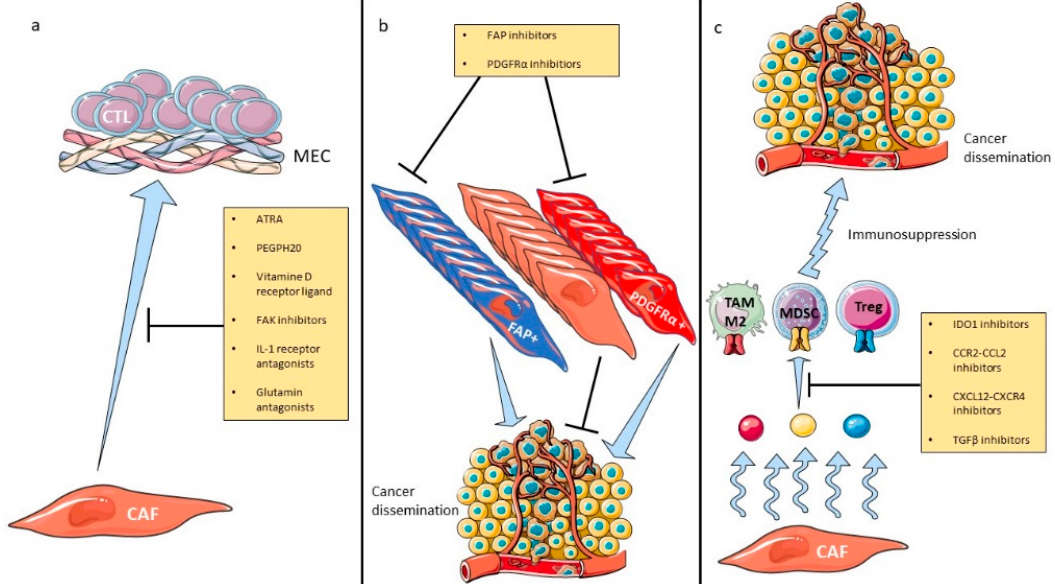
Figure 1. Therapeutic strategies modulating CAF activities. CAF-related drugs, with or without ICI combination, inhibit fibrosis ( a ), CAF-protumoral subsets ( b ) or CAF-secreted immunosuppressive molecules ( c ). Abbreviations: CAF: cancer-associated fibroblasts, CCL2: chemokine-ligand 2, CCR2: C-C chemokine receptor type 2, CXCL12: C-X-C motif chemokine 12, CXCR4: C-X-C motif chemokine